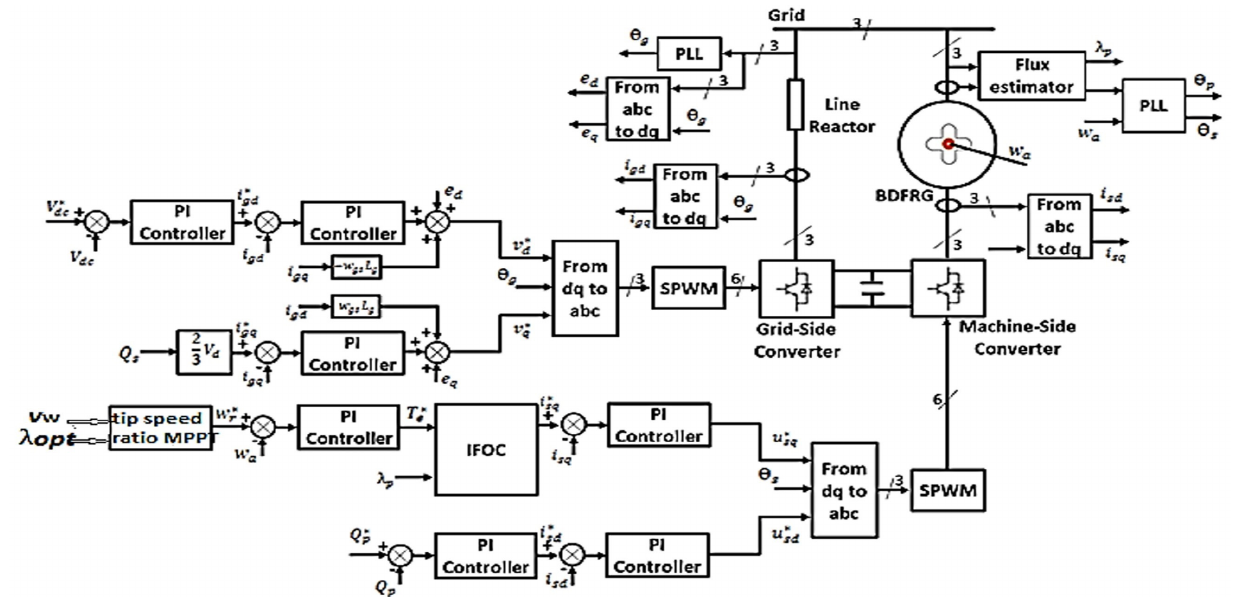
Figure 1. Block diagram of the studied